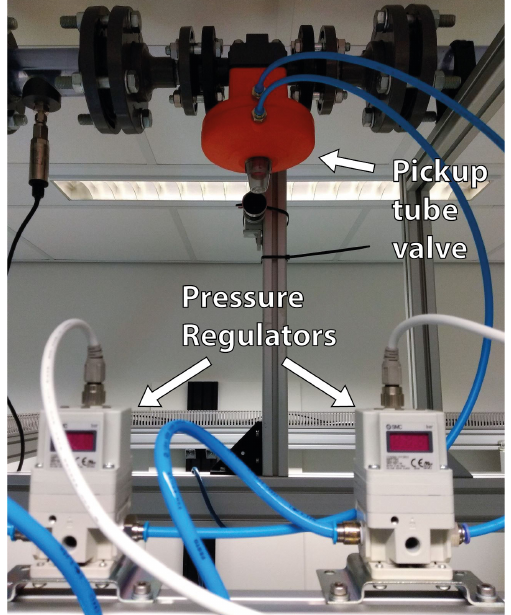
Figure 11. Pickup tube valve (orange) with its two pressure regulators (light